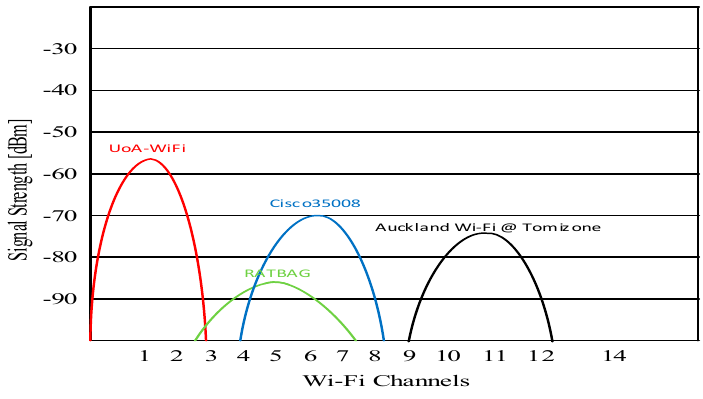
Figure 18. Measured 2.45 GHz Wi-Fi signal strength inside the indoor area.